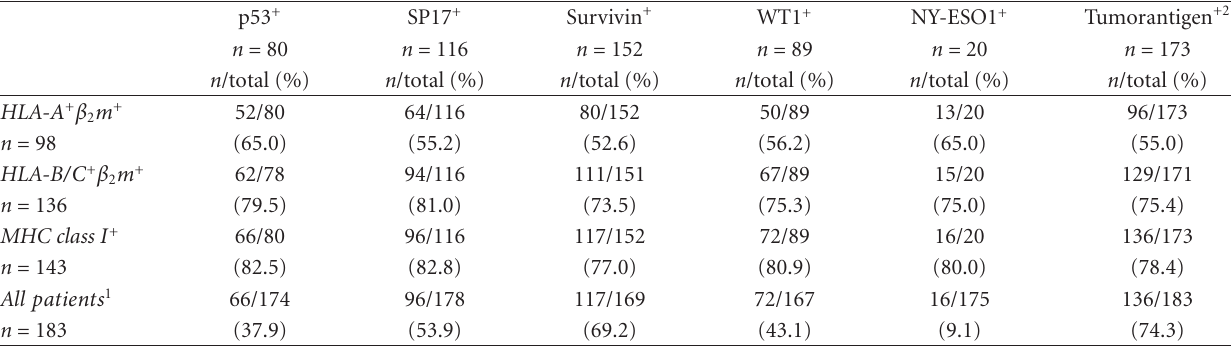
Table 6: Coexpression of MHC class I components with